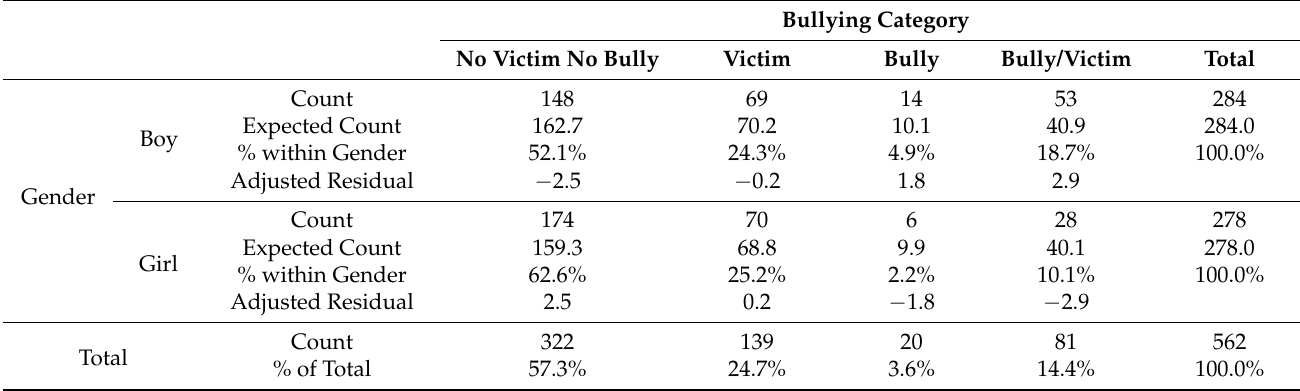
Table 1. Comparison of bullying categories based on gender.